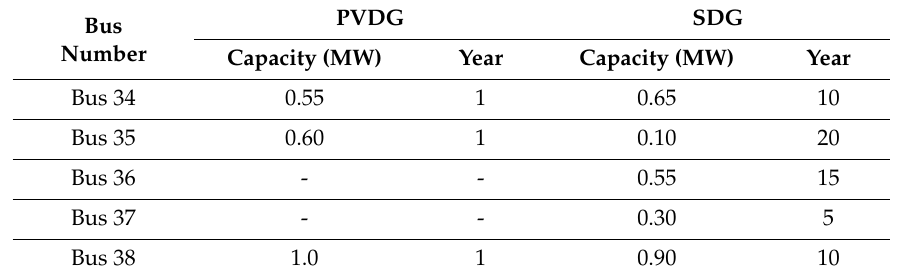
Table 2. Optimal Allocation of DG Units.